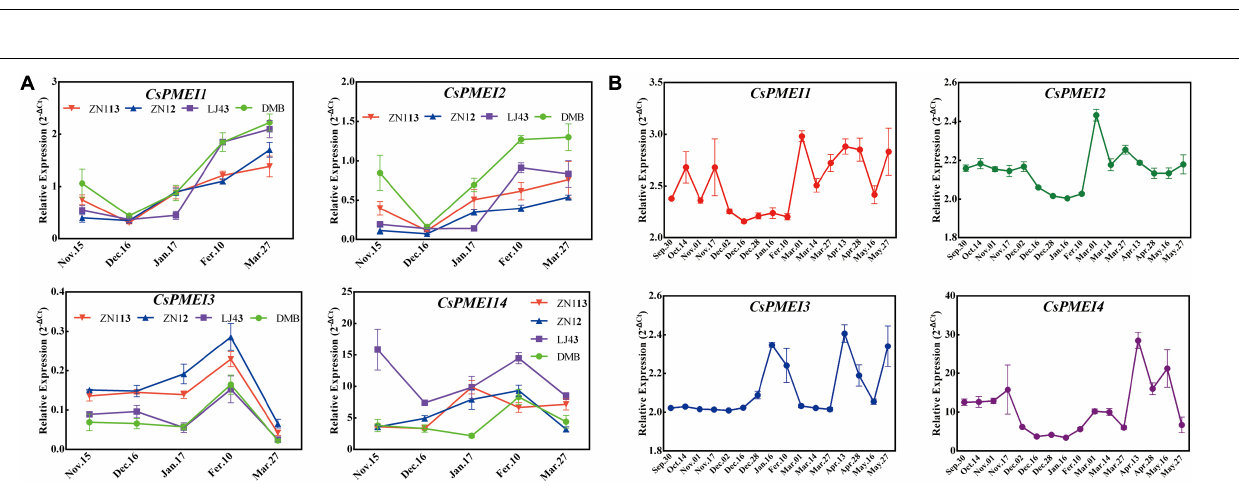
Frontiers in Plant Science |